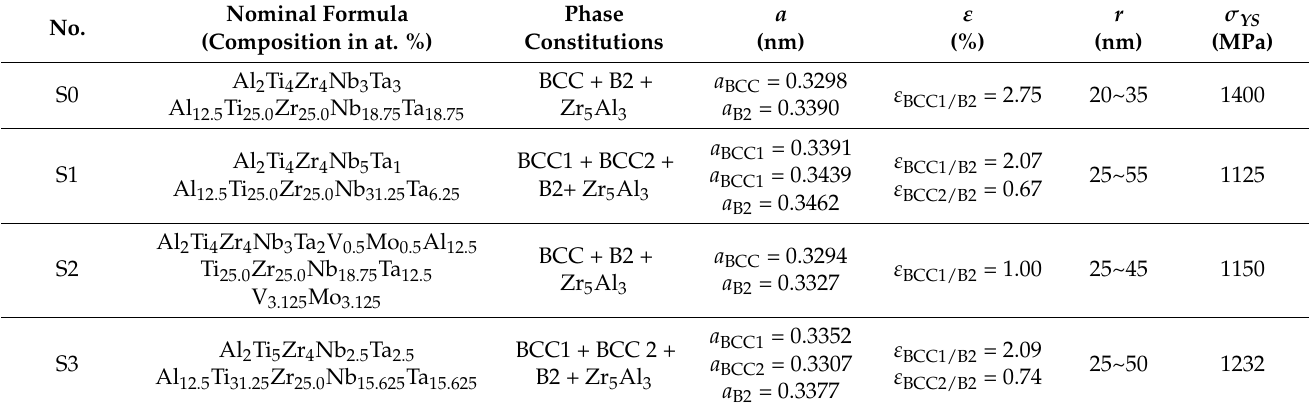
Table 1. Data summary for the designed RHEAs at 873 K-aged state, including nominal formula and composition in atomic percent (at. %), phase constitutions, lattice constants ( a ), lattice misfit ( ε ), particle size ( r ) of B2 and BCC2 nanoprecipitates and compressive yield strength ( σ YS